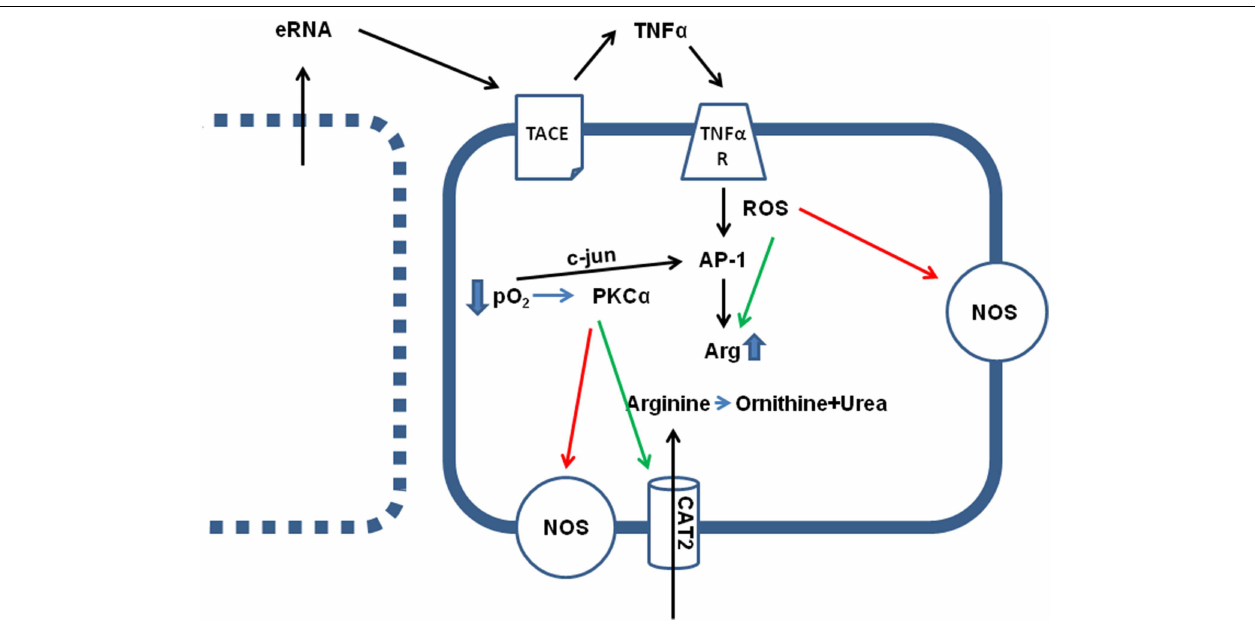
left), leading to the release of intracellular particles, such as RNA (eRNA), that activates a sheddase (TACE) thereby releasing TNF α . TNF α augments the hypoxia-induced cell damage by activation of AP-1 and increasing arginase (Arg) expression, by activation of arginase activity via nitrosylation and reducing the K M value for the enzymatic reaction, and ROS-dependent inhibition of NOS